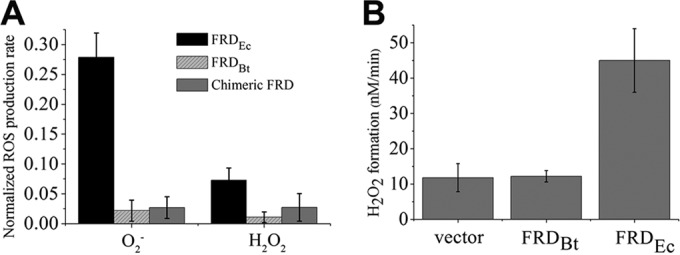
The absence of ROS production by B. thetaiotaomicron FRD does not derive from the lipid composition or the nature of its flavoprotein subunit. (A) Cell membranes were prepared from E. coli Hpx− cells, from cells of the the E. coli Hpx− Δfrd mutant carrying a plasmid expressing B. thetaiotaomicron wild-type Frd (frdCBA), and from cells of the E. coli Hpx− Δfrd mutant expressing the chimeric Frd (E. coli frdA plus B. thetaiotaomicron frdBC). The rates of in vitro O2− and H2O2 production are normalized to the succinate:plumbagin oxidoreductase activities. Reaction mixtures contained 0.4 mM succinate; 3 mM KCN was included in measurements of O2− formation. (B) Only E. coli Frd generates H2O2
in vivo. The E. coli Hpx− ΔfrdABCD strain LC126 was transformed with empty vector, plasmid pfrd(CAB)Bt expressing B. thetaiotaomicron Frd, or plasmid pH3 expressing E. coli Frd. Fumarate reductase was induced in anoxic lactose-Casamino Acids medium, and H2O2 excretion was then quantified after dilution into oxic glucose buffer (see Materials and Methods).